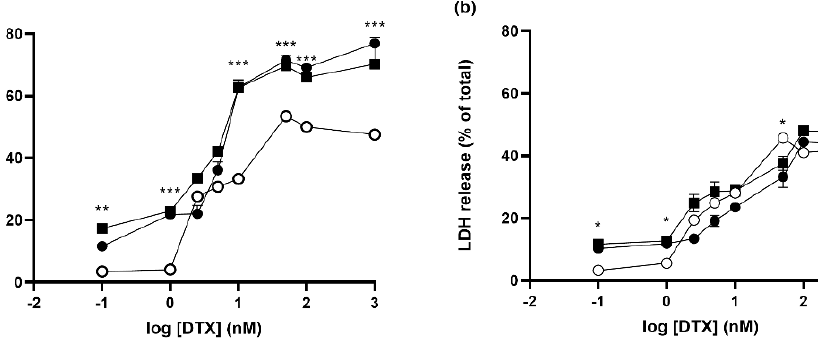
Figure 6. Effect of SCR-siRNA ( ■ ; 100 nM) or double p42- MAPK/Rheb knockdown (●) on DTX ( ○ )- induced toxicity in ( a ) LNCaP and ( b ) PC3 cells. Data represent mean ± SEM of 24 to 100 experiments for SCR-siRNA treated or 15 to 240 individual determinations for knockdown experiments. DTX dose–response curves in the absence of siRNA are the same as those shown in Figure S9. If absent, error bars are smaller than the symbol size. * p < 0.05, ** p < 0.01, *** p < 0.001 as compared to DTX in absence of siRNA. Table 1. DTX-induced toxicity and EC50 values. LNCaP prostate cancer cells were exposed to DTX (0.1 nM to 1 µM) alone or in the presence of different siRNA treatments for 72 h and toxicity deter- mined. Individual DTX dose – response curves were fitted to a log concentration versus response model. Data represent mean ± SEM of 5 to 12 experiments.